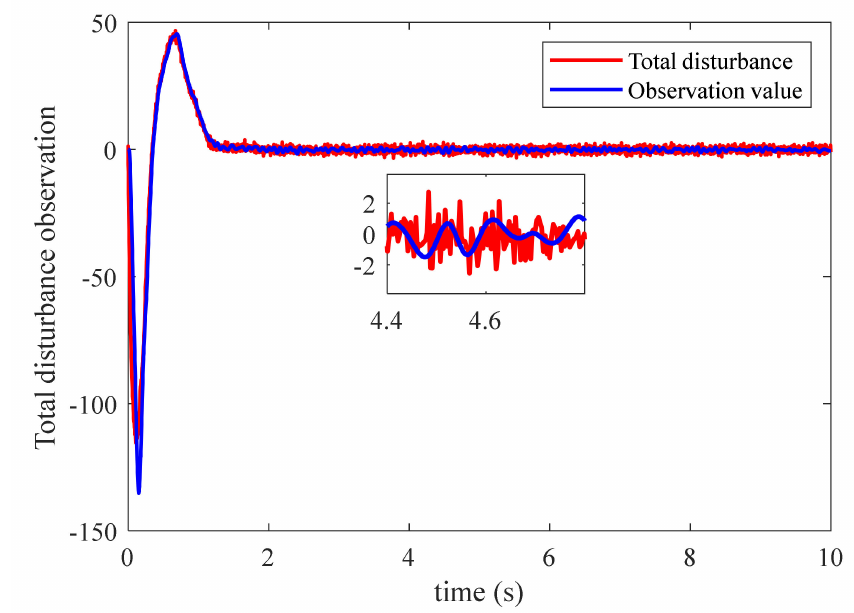
Figure 15. Time response of total disturbance